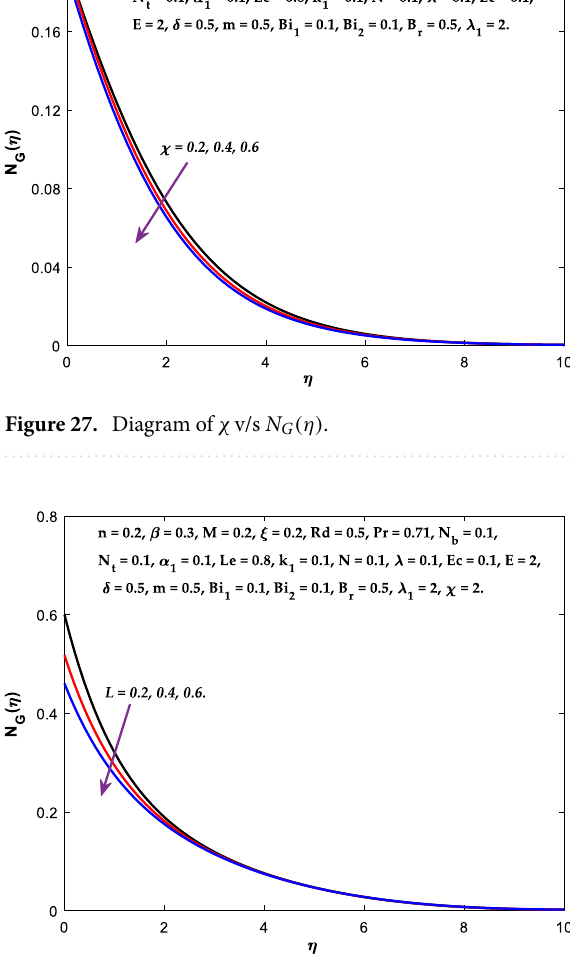
Figure 28. Diagram of L v/s N G (η) .